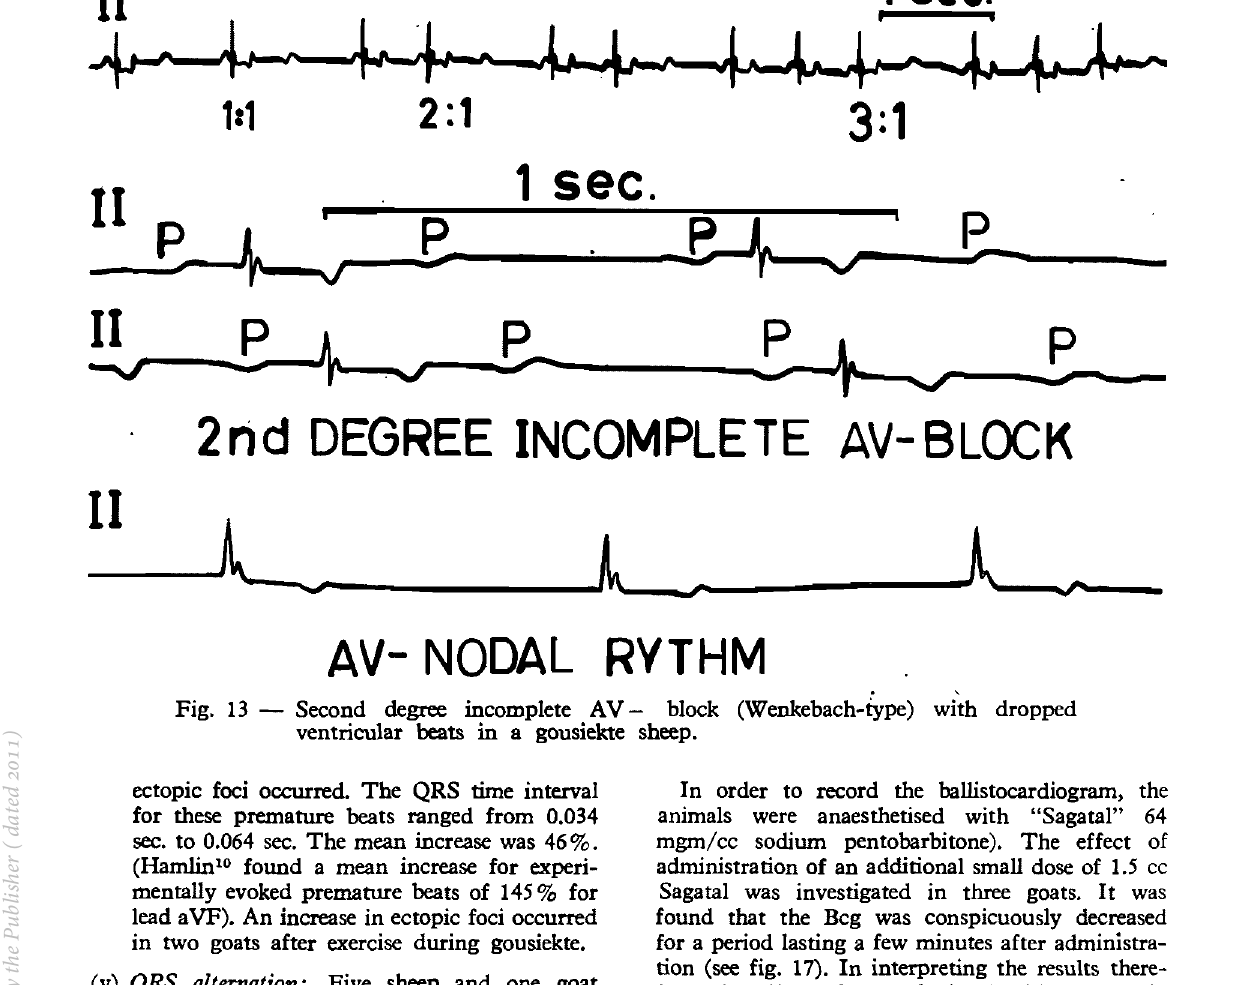
Fig. 13 - Second degree incomplete AV - block (Wenkebach-iype) with dropped ventricular beats in a gousiekte sheep. ectopic foci occurred. The QRS time